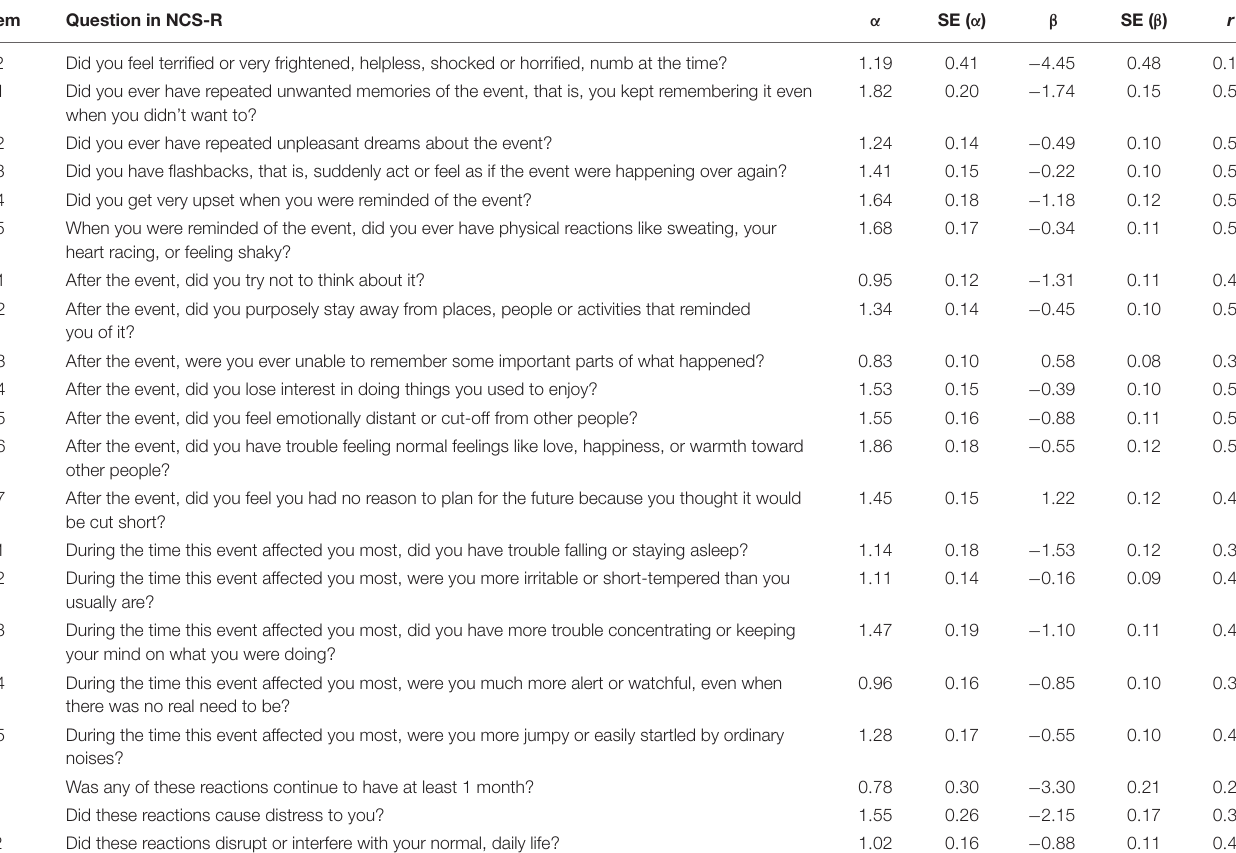
TABLE 1 | Item Parameters of 21 Questions Related to PTSD in NCS-R (calibrated with n = 880).